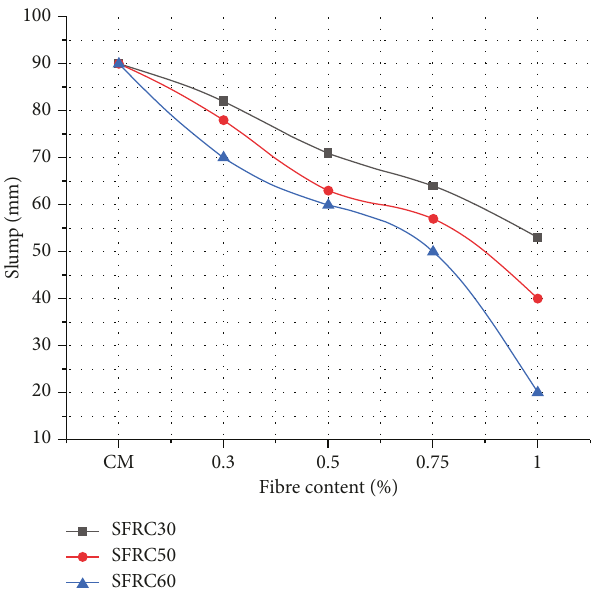
Figure 8: Effect of fibres on the workability performance of high- strength